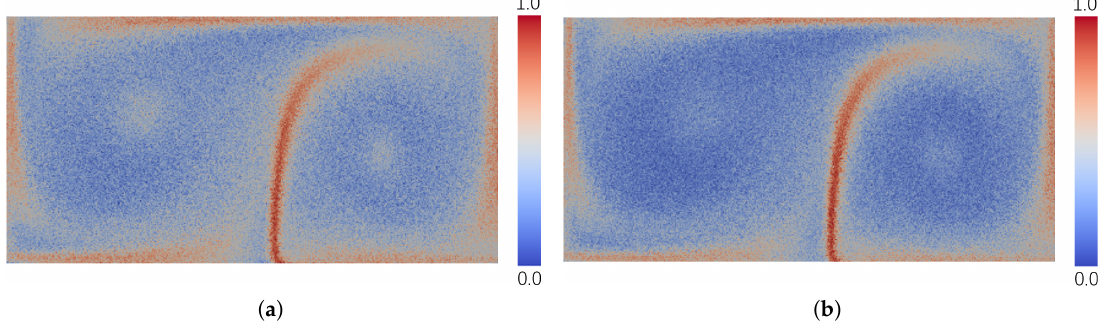
Figure 16. AEDR results for DG data set using different thresholds: ( a ) AEDR result with δ = 20, and ( b ) AEDR result with δ =